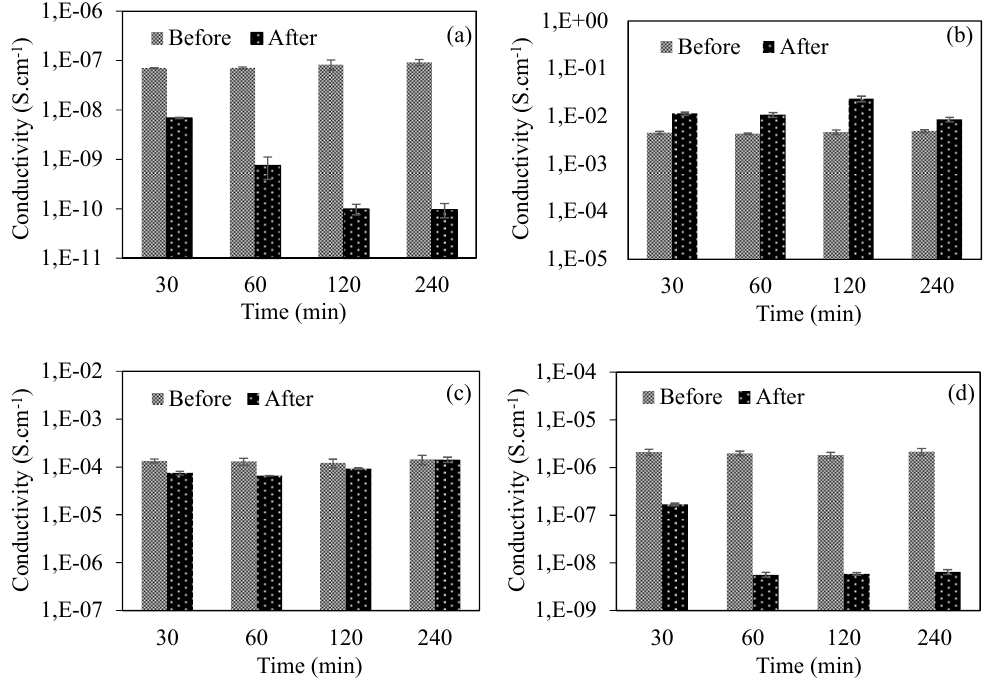
Figure 4. The change in conductivities of ( a ) bare PEI cryogel, ( b ) PEI / PANi, ( c ) PEI / PPy, and ( d ) PEI / PTh cryogel composites under CO 2 gas exposure. [200 mL / min flow rate].